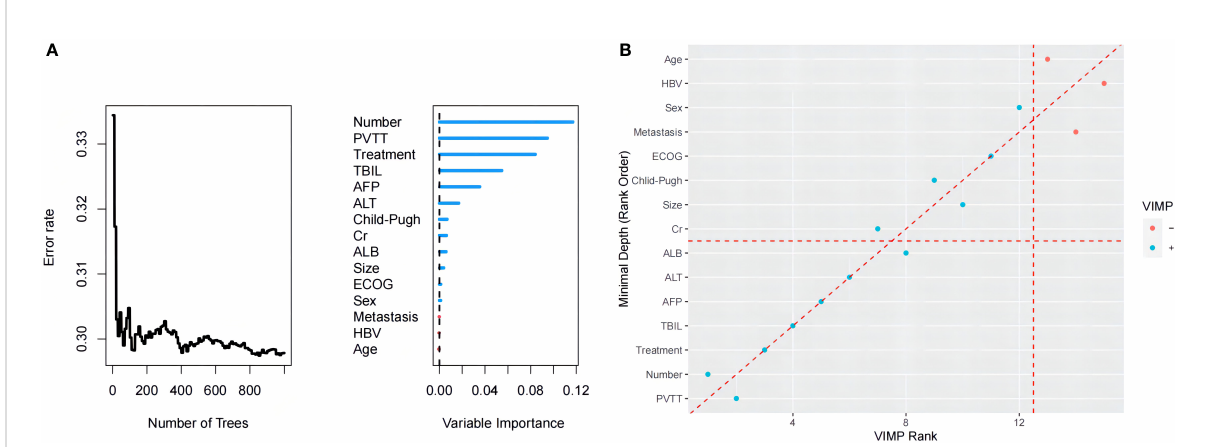
FIGURE 4 (A) Order of importance of the variables in the RF model for OS. (B) The blue point represents a VIMP value > 0, the red a value < 0; the point on the red diagonal dashed line represents the same ranking of the two methods on the variable, and the point higher than the diagonal dashed line represents its VIMP ranking. Higher points below the diagonal dotted line represent a higher minimum depth